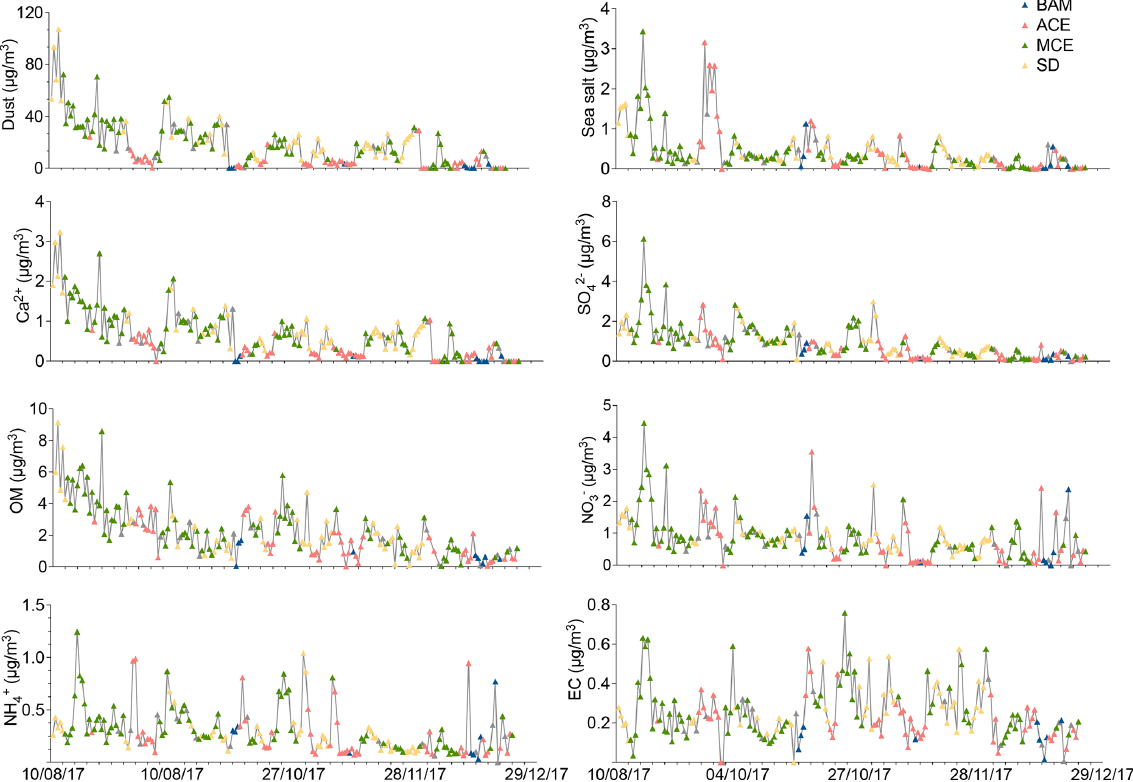
Figure 5. Time series of major aerosol chemical constituents in PM 10 filter samples collected from August to December 2017. The color of the symbols displayed for each sample represents a specific air mass origin: background (blue); ACE (red); MCE (green); SD